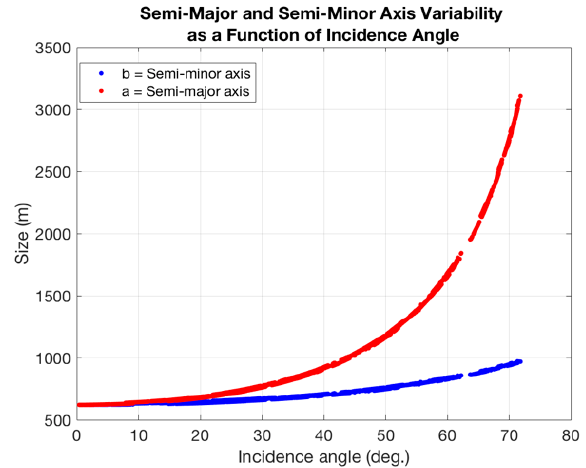
Figure 1. Semi-minor ( b in Equation (3), n = 1) and semi-major ( a in Equation (2), n = 1) axis dimensions of the first Fresnel zone as they vary with incidence angles associated with CYGNSS data. The size of the ellipse defining the first Fresnel zone varies: semi-major axis varies from 600 m to 2.8 km and semi-minor axis varies from 600 m to 1 km for incidence angles below 70 ◦ .